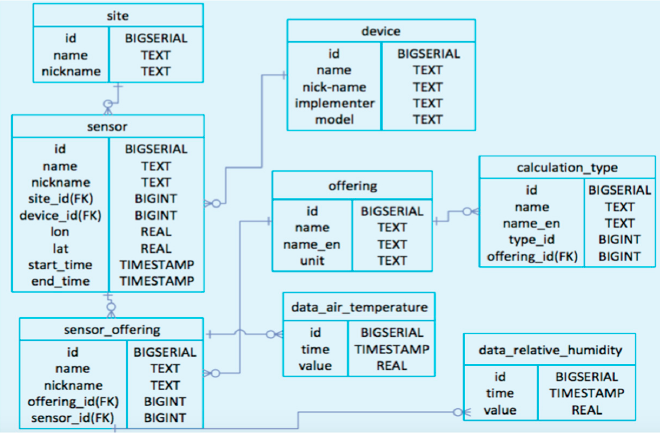
Figure 11. ER chart of database structure.